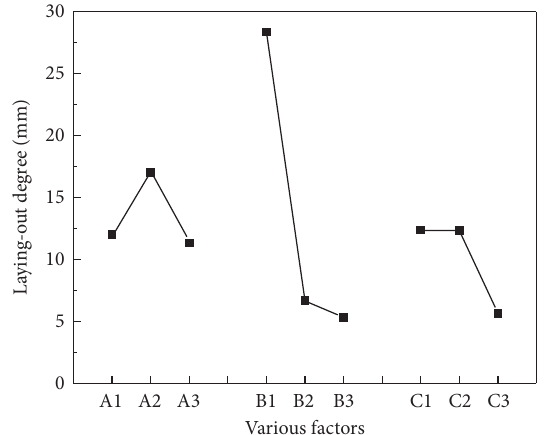
Figure 6: The tendency of segregation degree and factor level of paste filling.